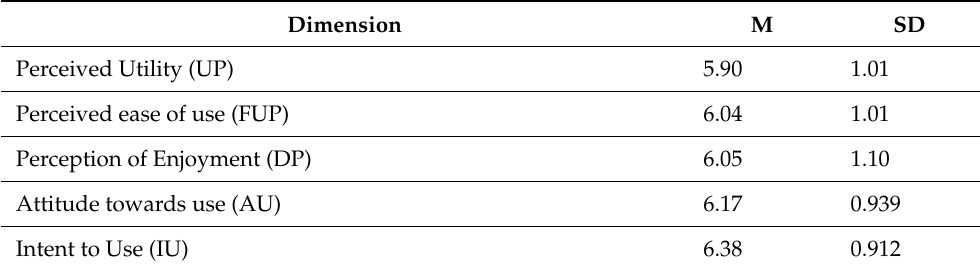
Table 3. Means and standard deviations in the different dimensions of the TAM. Dimension